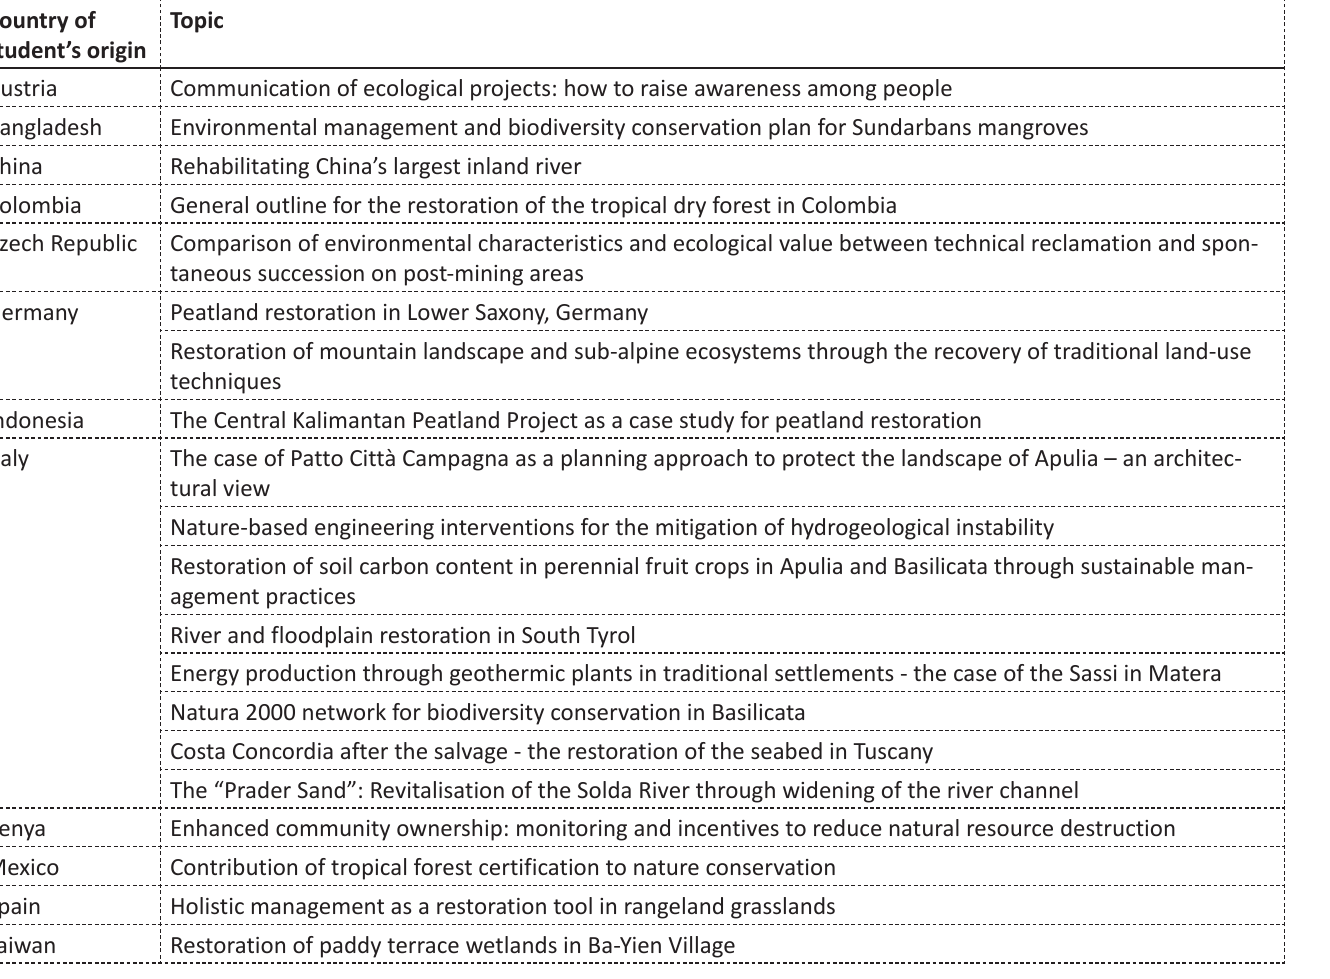
Table 5: Topics of students’ presentations on the summer school in Matera in 2015 with case studies from their country of origin. Country